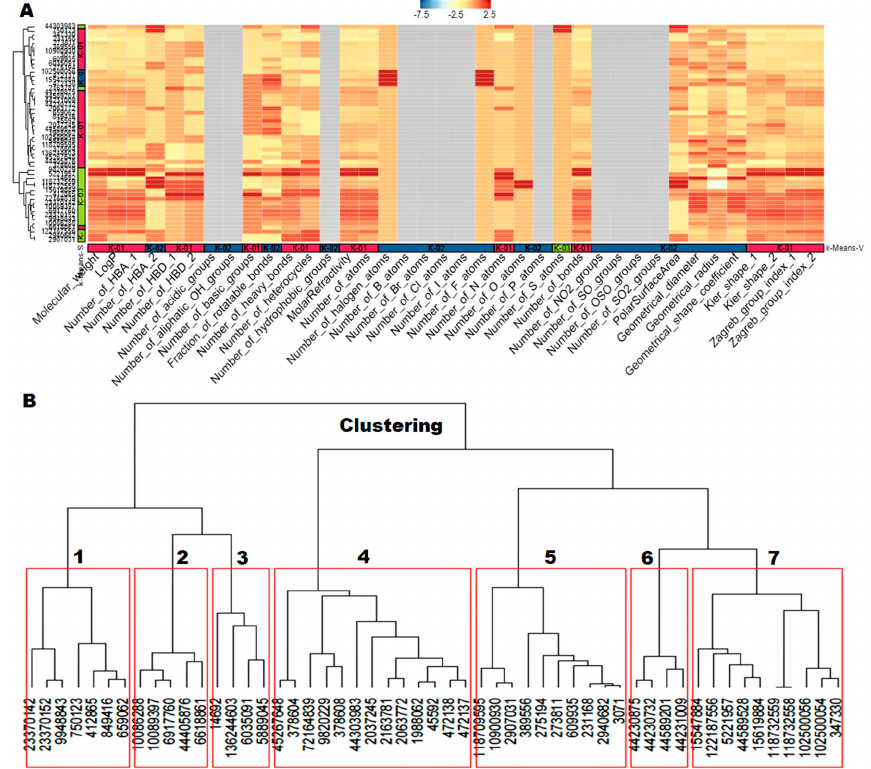
Figure 3. The molecular descriptors and clustering of 53 hit molecules. ( A ) The molecular descriptors were represented as a heatmap. It showed positive values as a red color and negative values as a blue color. ( B ) The molecular descriptors were classified as hierarchical clustering trees. The hierarchical clustering showed seven cluster trees. Cluster 1 has four compounds, Cluster 2 and Cluster 3 have ten compounds each, Cluster 4 has fourteen compounds, Cluster 5 has four compounds, Cluster 6 has five compounds, and Cluster 7 has seven compounds, respectively.